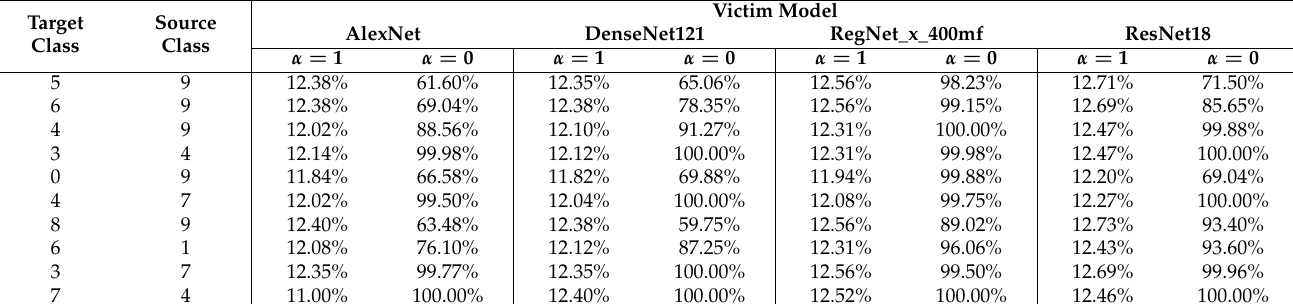
Table 5. Comparisons of TSR of STUAE on EuroSAT when alpha = 0 and alpha = 1.